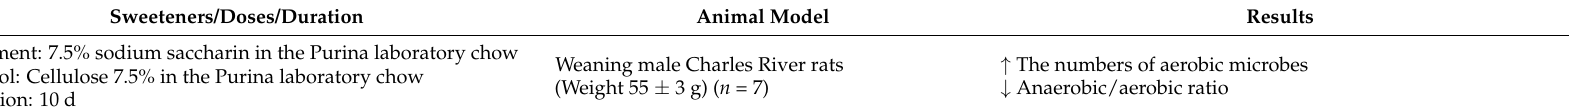
Table 4. Evidence from animal model studies relative to sucralose and saccharin effects on the gut